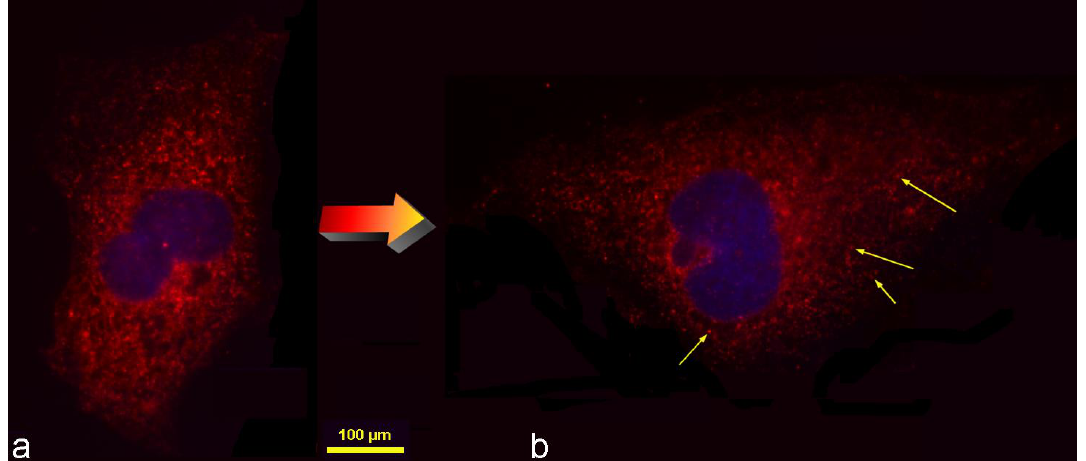
Figure 7. Lysosomal-associated membrane protein 1 (LAMP1) red stains achieved by the transient transfection of control cells ( a ) and cells challenged with nanoparticles ( b ) with LAMP1-YFP. Nuclear DNA was stained in blue using DAPI. Yellow arrows in ( b ) indicate the slightly elongated or misshaped lysosomes coexisting with their spherical counterparts and mostly prominent in the cells undergoing the nanoparticle uptake.